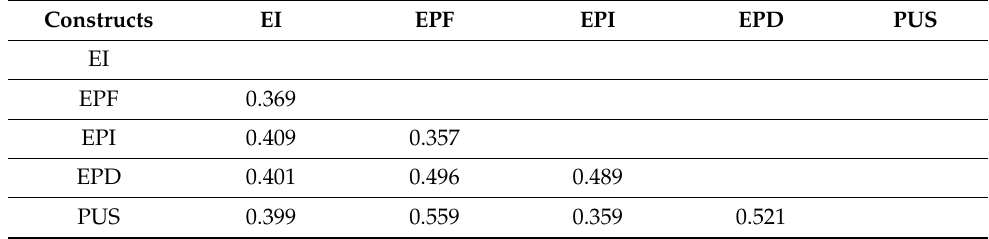
Table 3. Discriminant validity (HTMT Ratio).